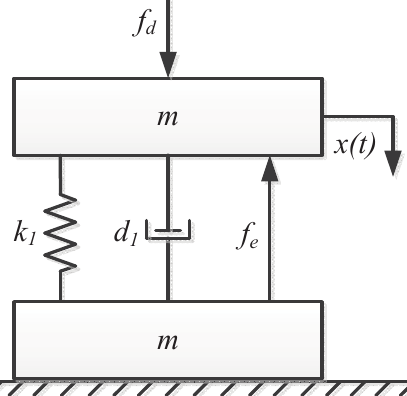
Figure 2. The model of the electromagnetic vibration isolation